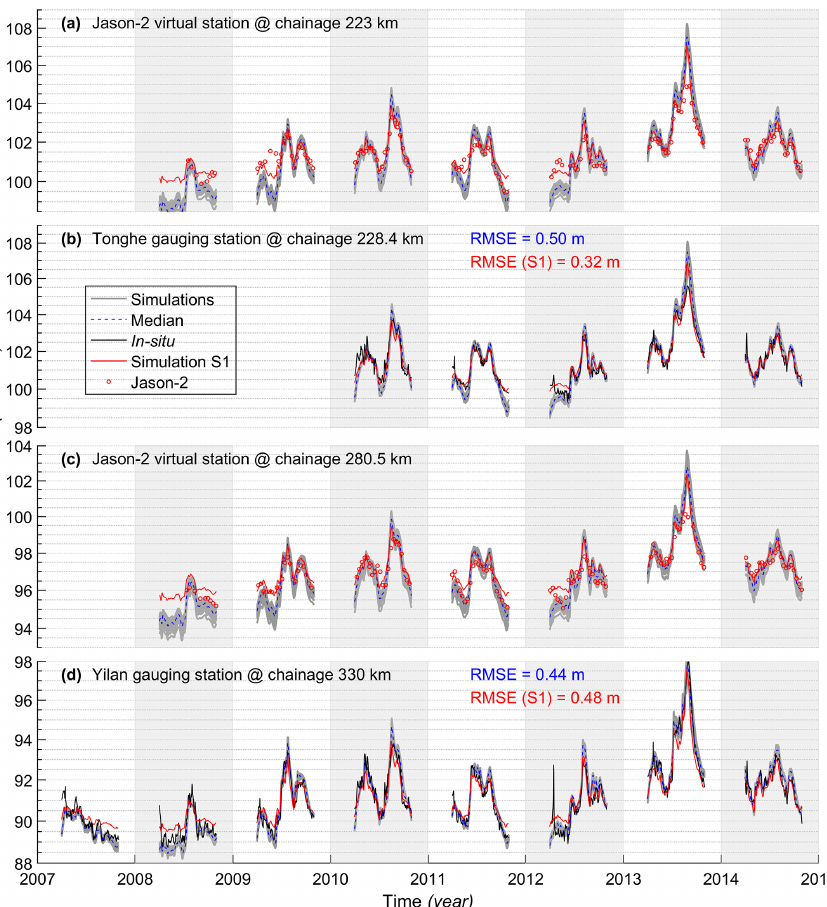
Figure 6. Validation of simulated water level (non-frozen periods) at four stations. Panels (a) and (c) are water levels at two virtual stations, i.e., data derived from Jason-2 altimetry. Panels (b) and (d) are from two stream gauging stations. Simulation from previous model calibrated using different strategy (i.e., simultaneous calibration of roughness and cross-section shape parameters; simulation S1 in Jiang et al., 2019) is also shown for comparison. Note that, in each plot, results of the median and individual simulations of an ensemble of 30 calibrations (#1, #2, and #3) are